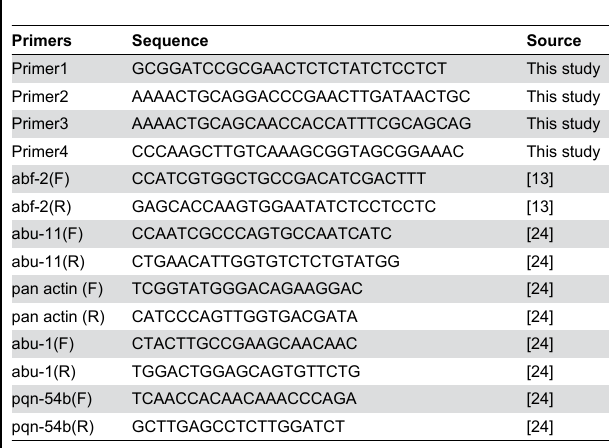
Table 1. Primers used in this